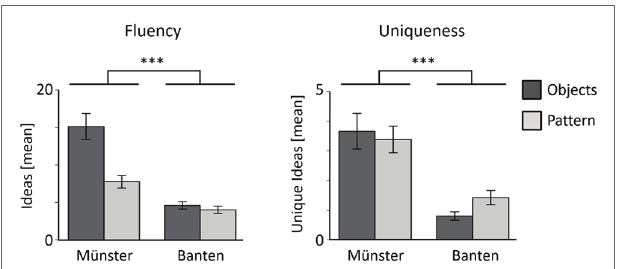
FIGURE 2 | The mean fluency and unique ideas for children from both cultures. Fluency corresponds to the mean number of ideas uttered by the children, per object. Uniqueness corresponds to the mean number of ideas only uttered by one child, per object. *** p < 0.001.